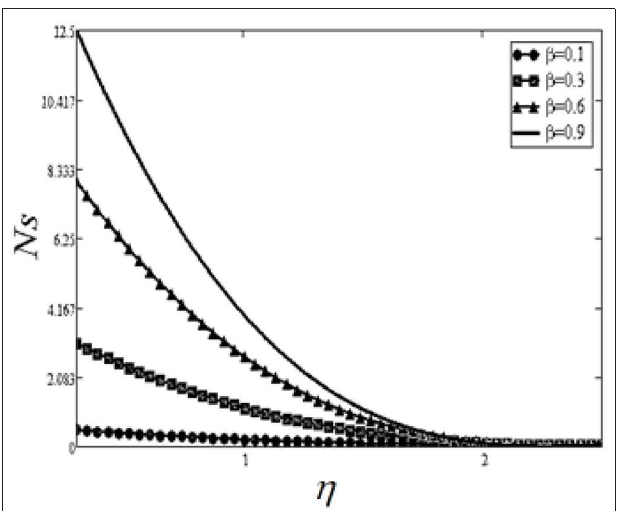
FIGURE 10 | Bejan number plot for